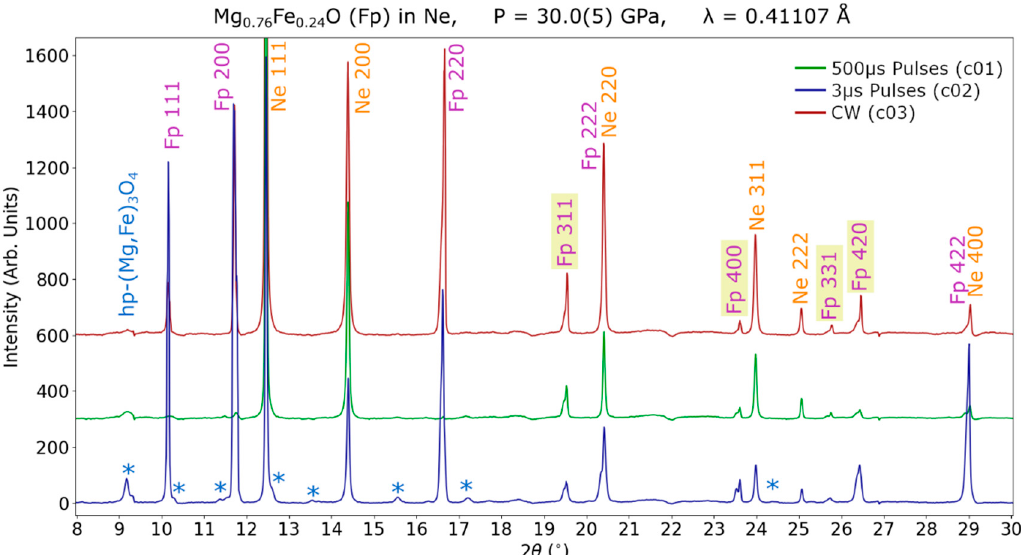
Figure 2. Representative powder diffraction patterns of crystals C01, C02 and C03 of Experiment 1 at 30 GPa, after being laser-heated correspondingly by CW, short (3 μ s), and long (500 μ s) pulses. Diamond reflections have been masked. Reflections (331), (400), (331) and (420) of ferropericlase (highlighted) are visibly broadened or split; asterisks mark the most prominent reflections of hp-(Mg,Fe) 3 O 4 phase formed after laser heating.